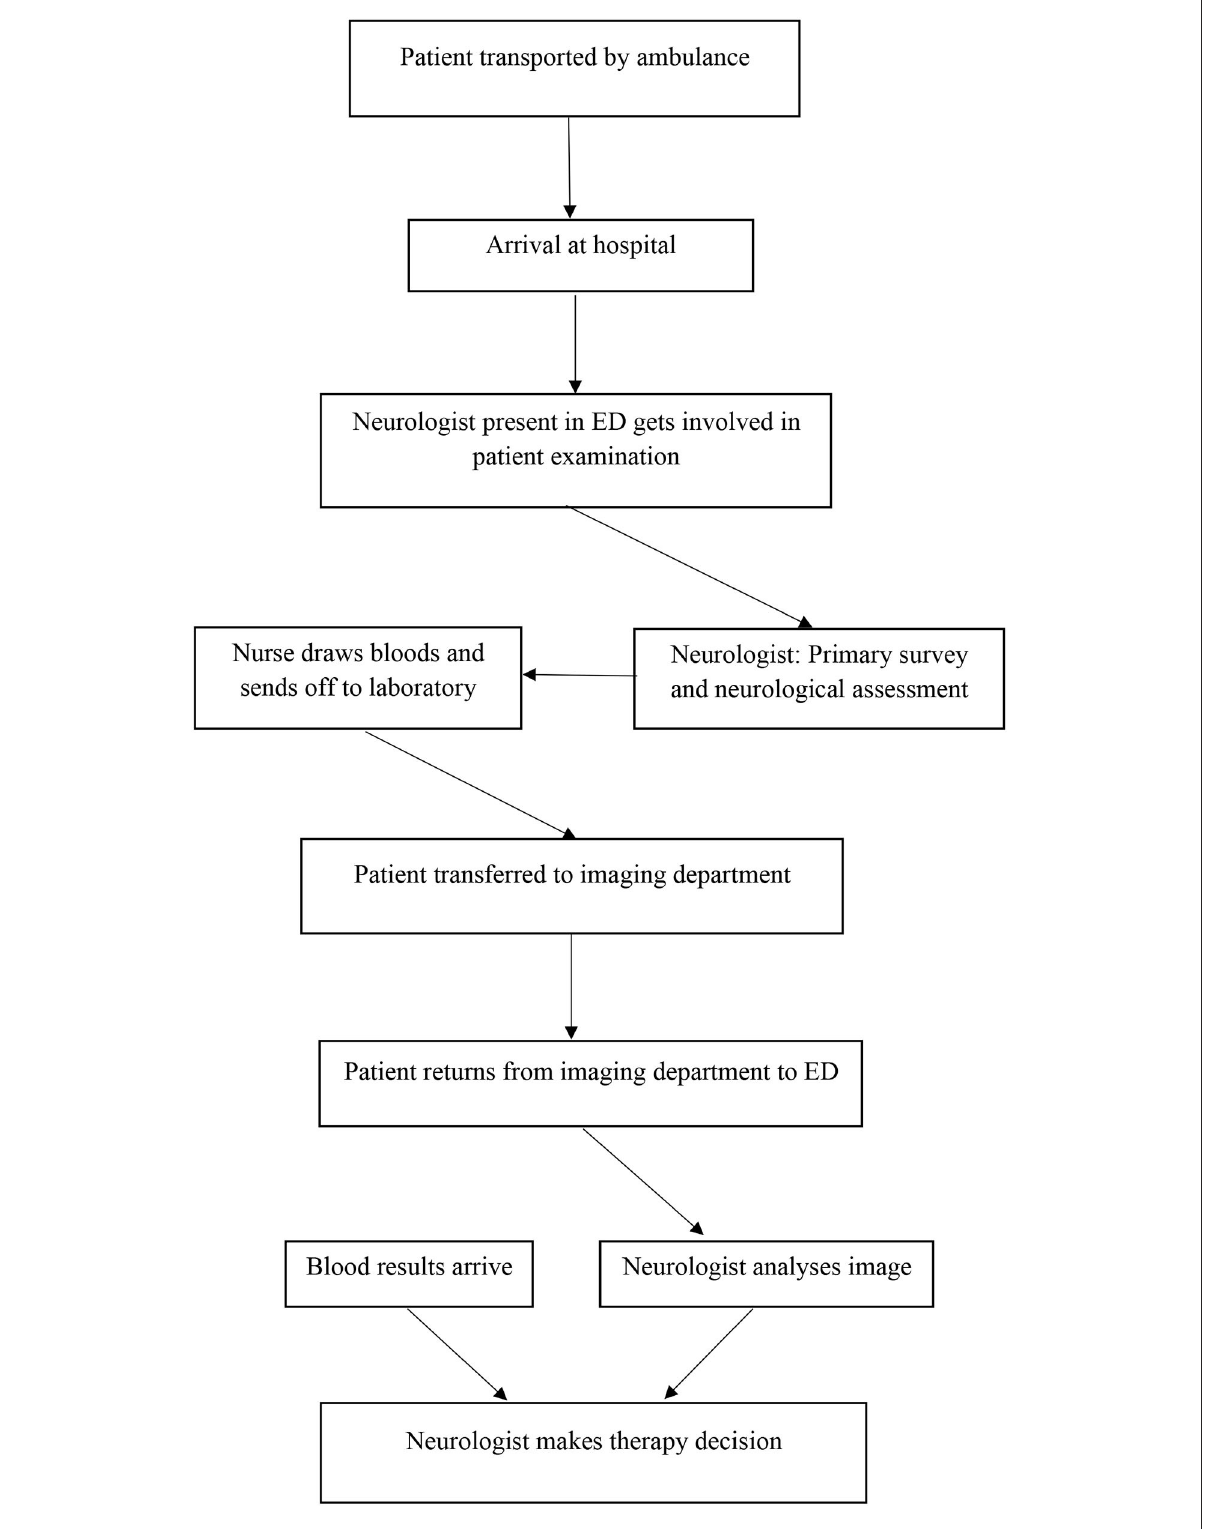
FIGURE2 In-hospital workflow in the studied